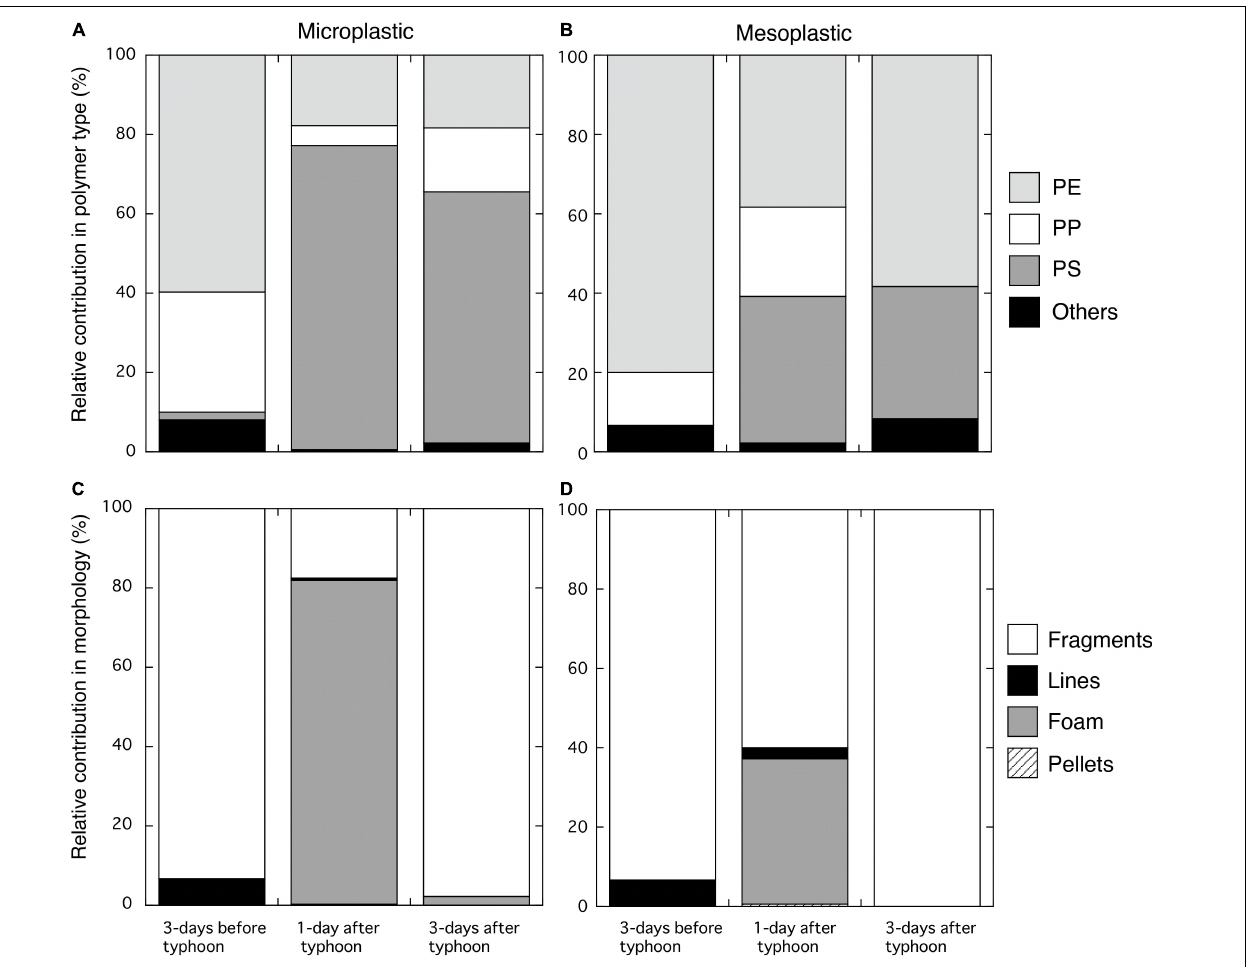
FIGURE 3 | Changes in the composition of (A,B) polymer type and (C,D) shape of microplastics and mesoplastics 1-day before and 1- and 3-days after the typhoon passage. PE, polyethylene; PP, polypropylene; PS, polystyrene. Fragments on (C,D) include hard fragments and films.